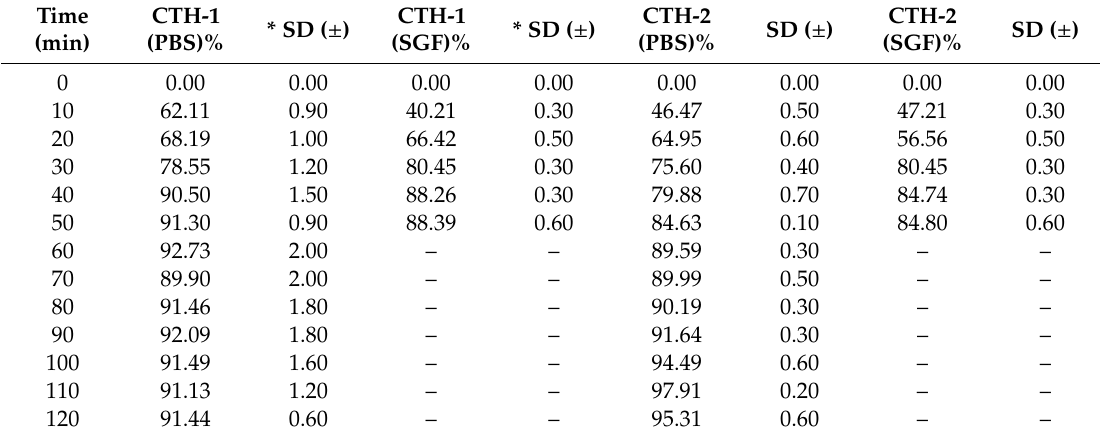
Table 7. Data on cumulative drug release (%) in SGF and PBS solutions.